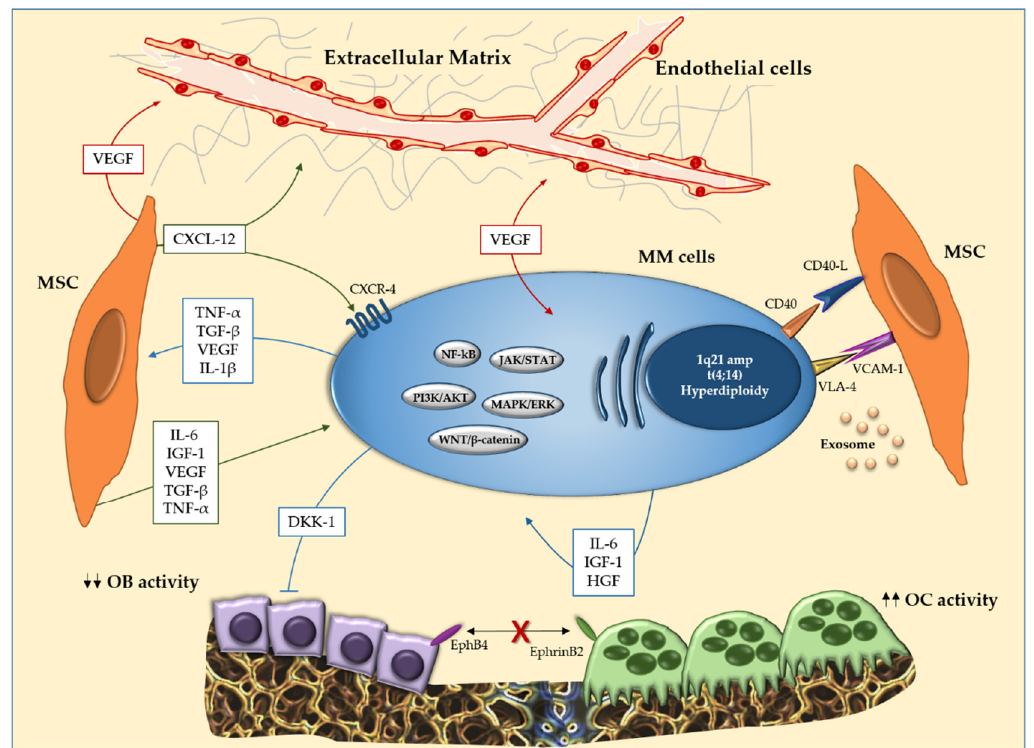
Figure 1. Interaction between multiple myeloma (MM) cells and bone marrow (BM) microenvironment cells. In the BM, the interaction between MM cells and mesenchymal stromal cells (MSCs) induces over-production of cytokines (IL-1 β , IL-6 and TNF- α ), soluble factors in the microenvironment and activation of molecular pathways (JAK/STAT, PI3K/AKT and WNT/ β -catenin) that support survival and proliferation of MM cells. In addition, the cellular interaction results in activation of osteoclastogenesis and inhibition of osteogenic differentiation. EphrinB2 (expressed on OCLs) and EphB4 (expressed on OBs) also reduce osteoblastogenesis. Abbreviations: MM: multiple myeloma; BM: bone marrow; MSCs: mesenchymal stromal cells; IL-1 β : interleukin-1 β ; IL-6: interleukin-6; TNF- α : tumor necrosis factor- α ; JAK/STAT: Janus kinase signal transducer and activator of transcription pathway; PI3K/AKT: phosphatidylinositol 3-kinase/protein kinase B signaling pathway; WNT/ β -catenin: Wingless/ β -catenin signaling pathway; OCLs: osteoclasts; OBs: osteoblasts.